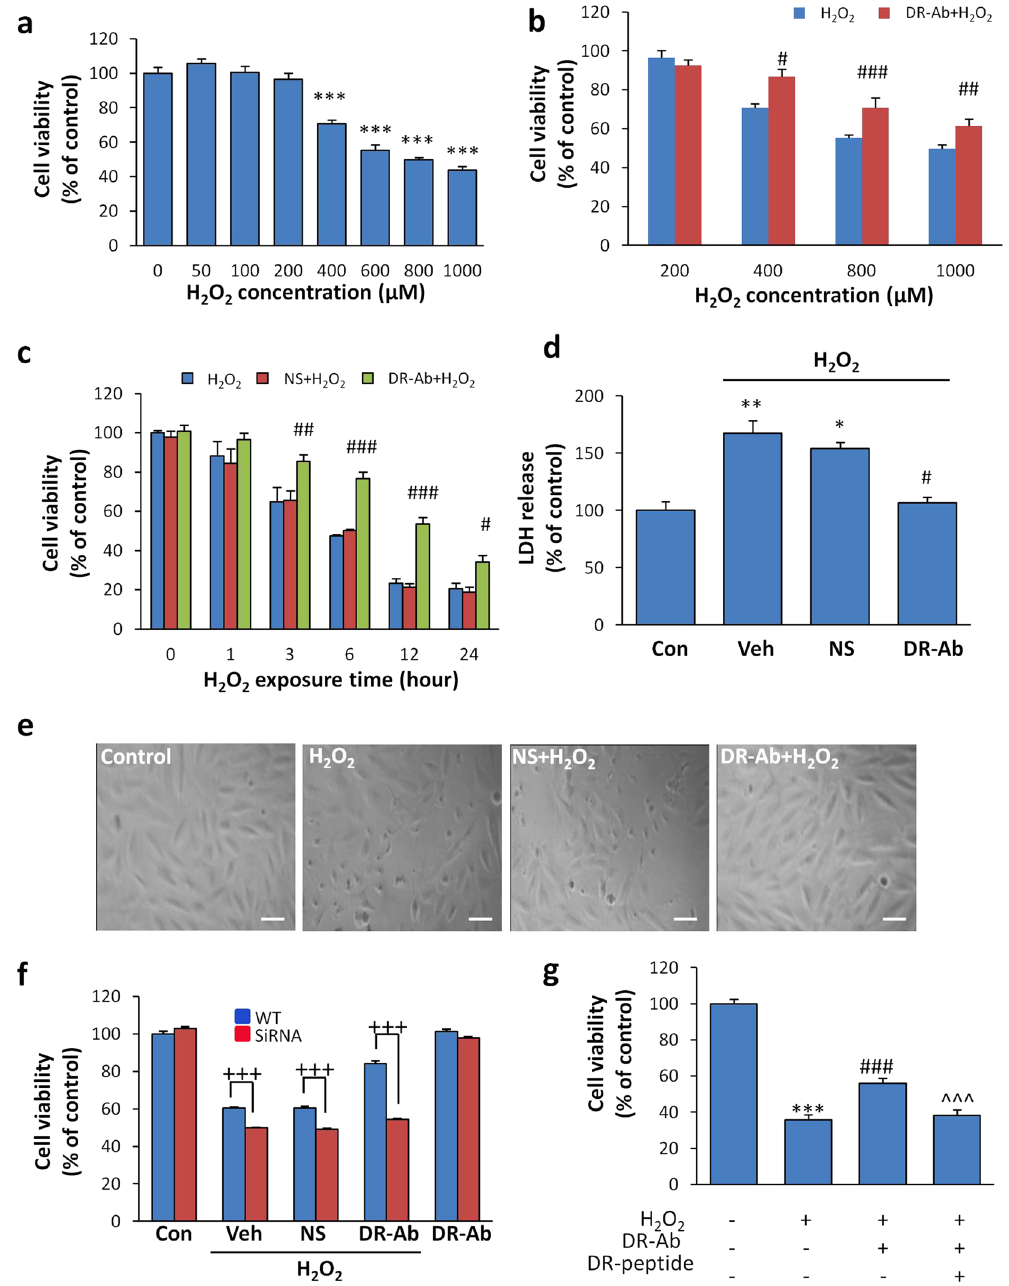
Figure 4. Effect of DR-Ab on ROS-induced injury in AC16 human cardiac myocytes or H9C2 rat myoblast cells. ( a ) Cytotoxicity induced by exposure to various concentrations of H 2 O 2 for 4 hours, as measured by MTT. n = 8; ( b ) Pretreatment with DR-Ab for 1 hr inhibits cell death caused by various concentrations of H 2 O 2 . n = 8; ( c ) Time-course study showing the protective effect lasted for at least 24 hr. n = 4–8; ( d ) H 2 O 2 increased LDH level in the culture media of H9C2 cells and DR-Ab pretreatment reduced it. n = 3. ( e ) Morphological changes (shrinking and detachment) in H 2 O 2 -treated H9C2 cells were absent in DR-Ab pretreated cells from three independent experiments; scale bar, 10 μ m; ( f ) Effect of NKA α 1 silencing on cell viability of AC16 cells under oxidative stress. n = 6; ( g ) Premixing DR-Ab with DR-peptide for 1 hour at room temperature under agitation abolished the protective effect of DR-Ab on AC16 cells. n = 8, Mean ± SEM. * p < 0.05, ** p < 0.01, *** p < 0.001 vs control, # p < 0.05, ## p < 0.01, ### p < 0.001 vs corresponding NS group. +++ p < 0.001 WT vs SiRNA; ^^^ p < 0.001 vs DR-Ab group. Con: control; Veh: Vehicle (PBS); NS: Rat normal antibody, as negative